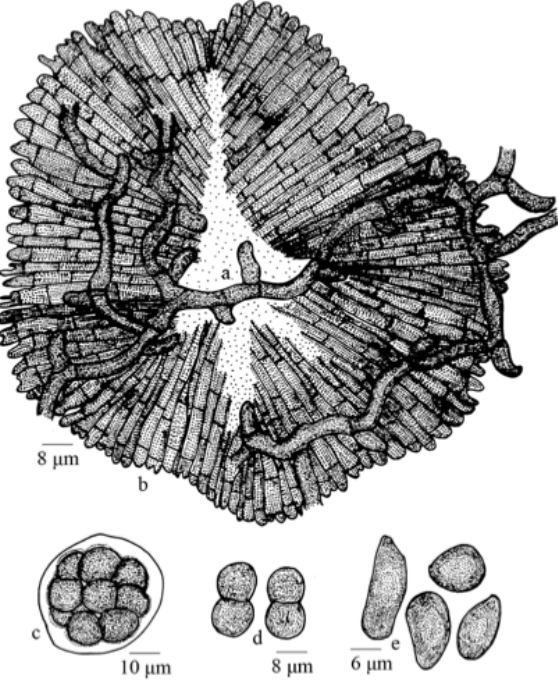
Figure 137. Asterina congesta a - Appressorium; b - Thyriothecium; c - Ascus; d - Ascospores; e. Pycnothyriospores